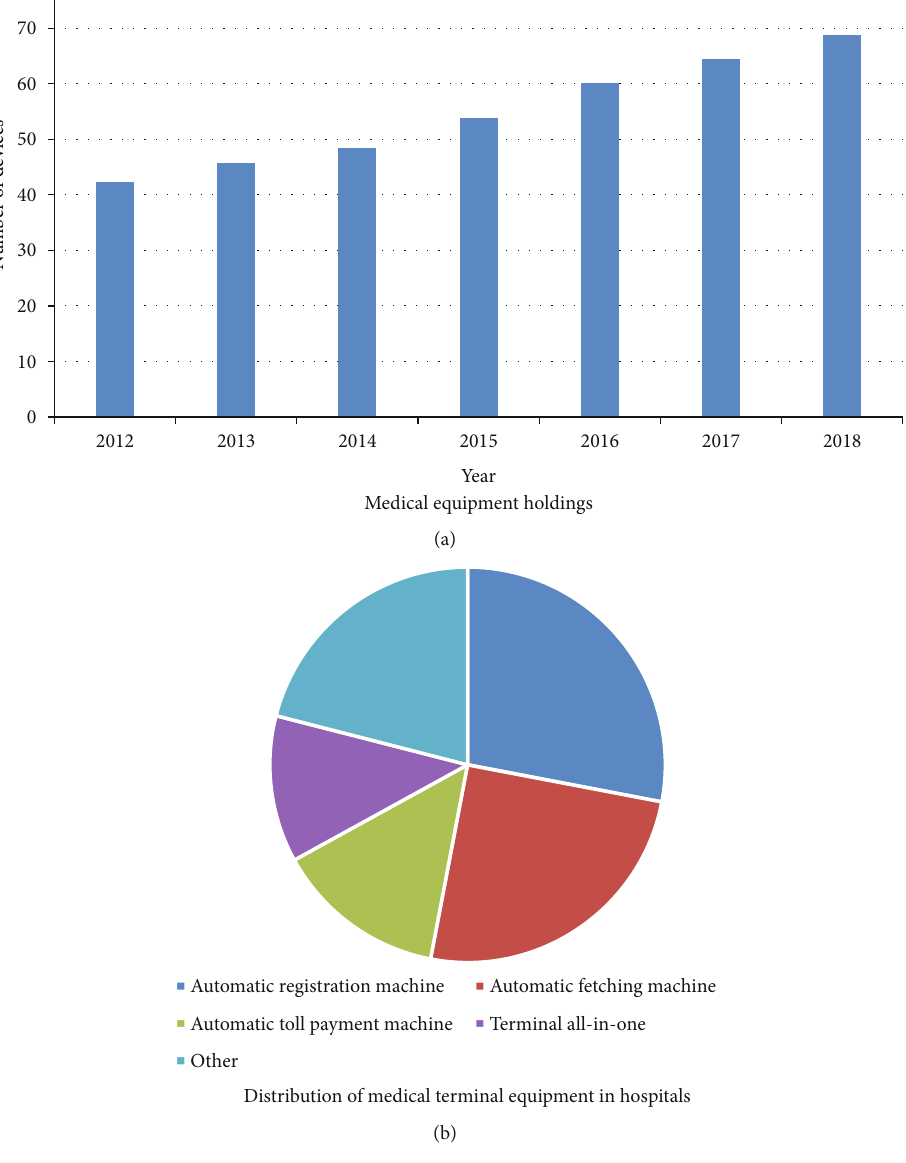
Figure 7: Status of medical service